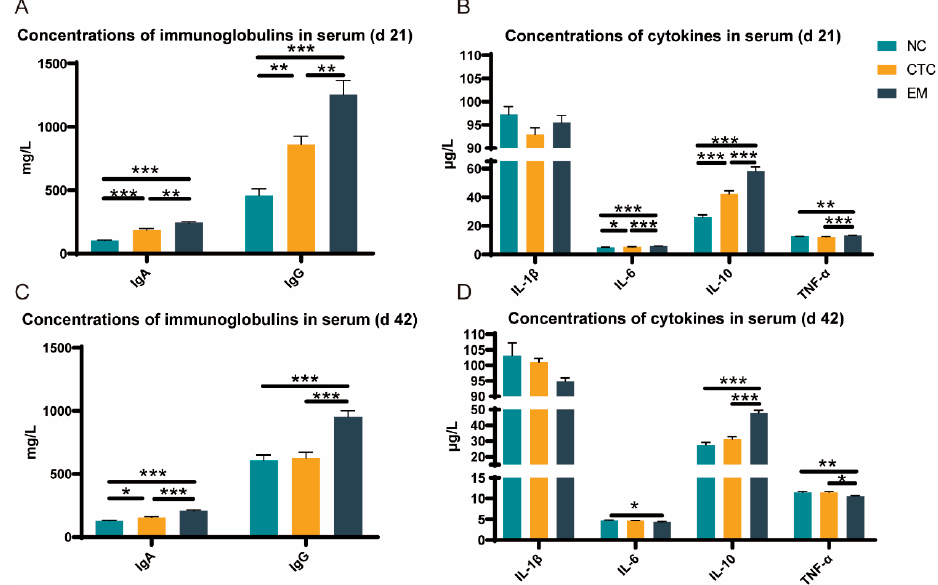
Figure 3. Effect of NC, CTC, and EM on serum immunoglobulins ( A ) and serum cytokines ( B ) at 21 d, and serum immunoglobulins ( C ) and serum cytokines ( D ) at 42 d in broilers. Significant differences were regarded as * p < 0.05, ** p < 0.01, *** p < 0.001. N = 6 per treatment group.